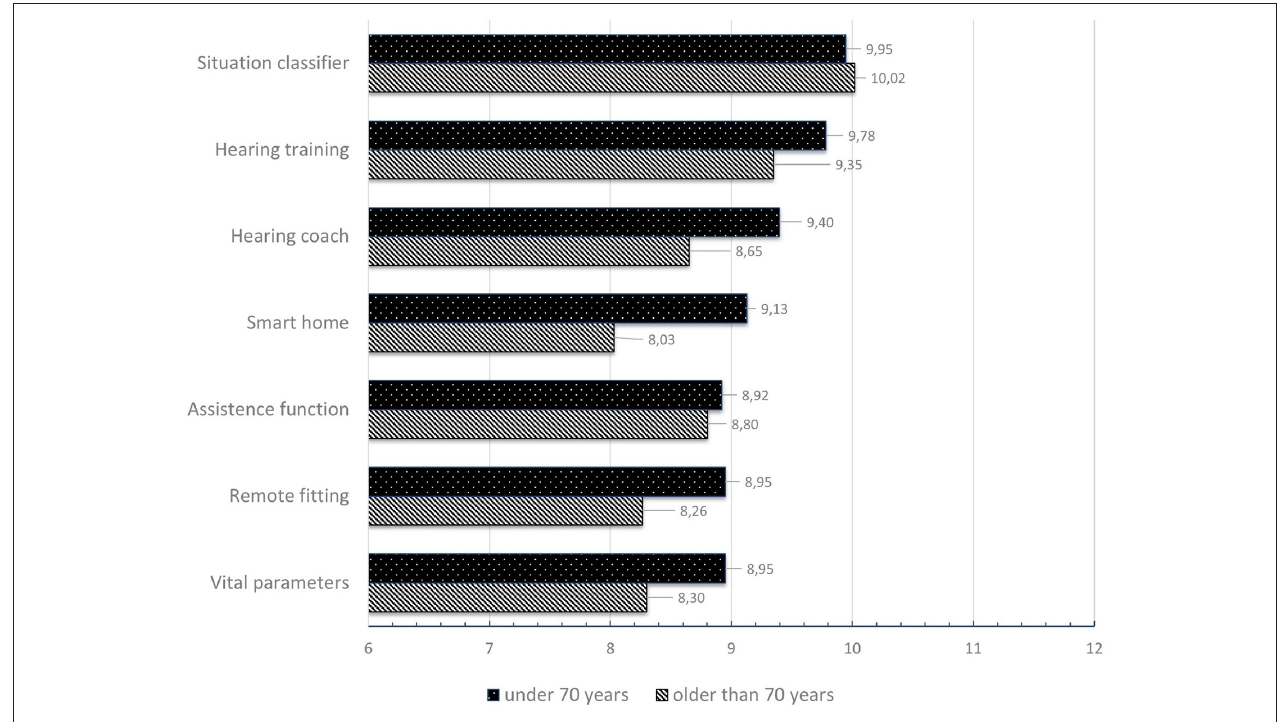
FIGURE 7 | Ranking of the preferred service technologies classified by age.